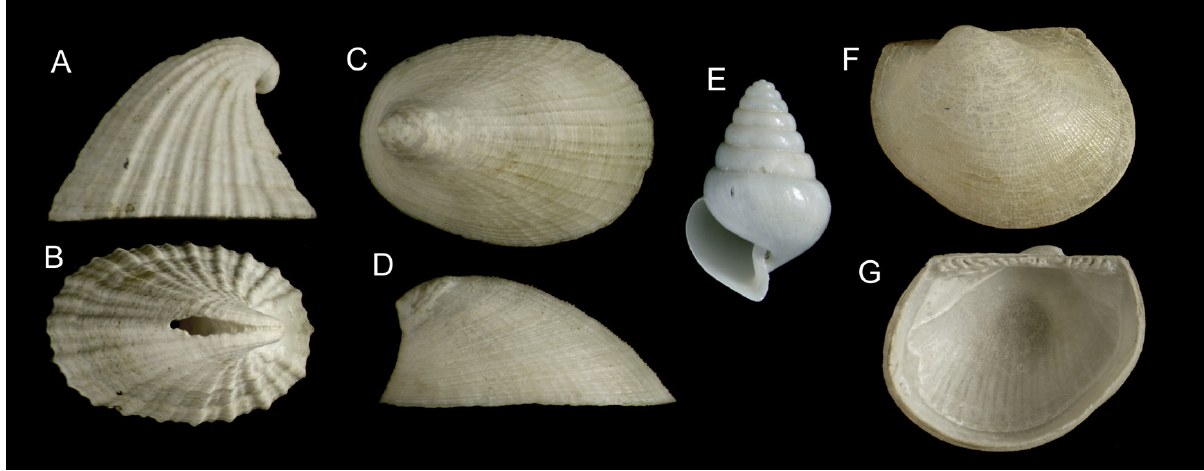
Fig. 5. – Molluscan species found only in thanatocoenosis on Algarrobo Bank. A-B: Puncturella noachina (length 5 mm). C-D: Iothia fulva (length 5.5 mm). E: Limacina retroversa (height 2.8 mm). F-G: Bathyarca frielei (length 8.5 mm, compare with B. pectunculoides Fig. 3